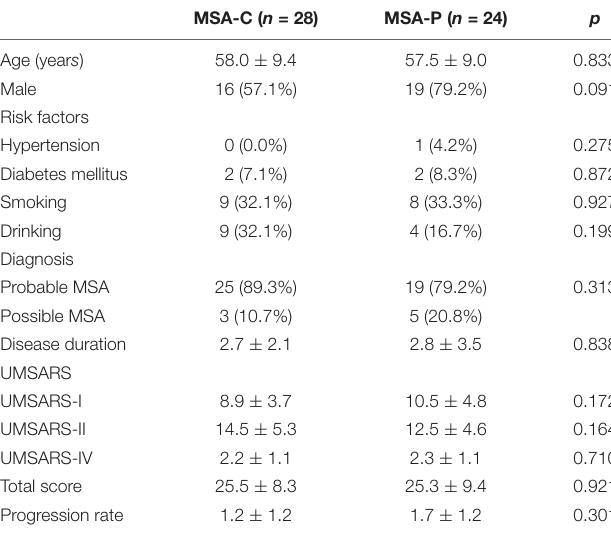
TABLE 2 | A comparison of clinical parameters between MSA-C and MSA-P